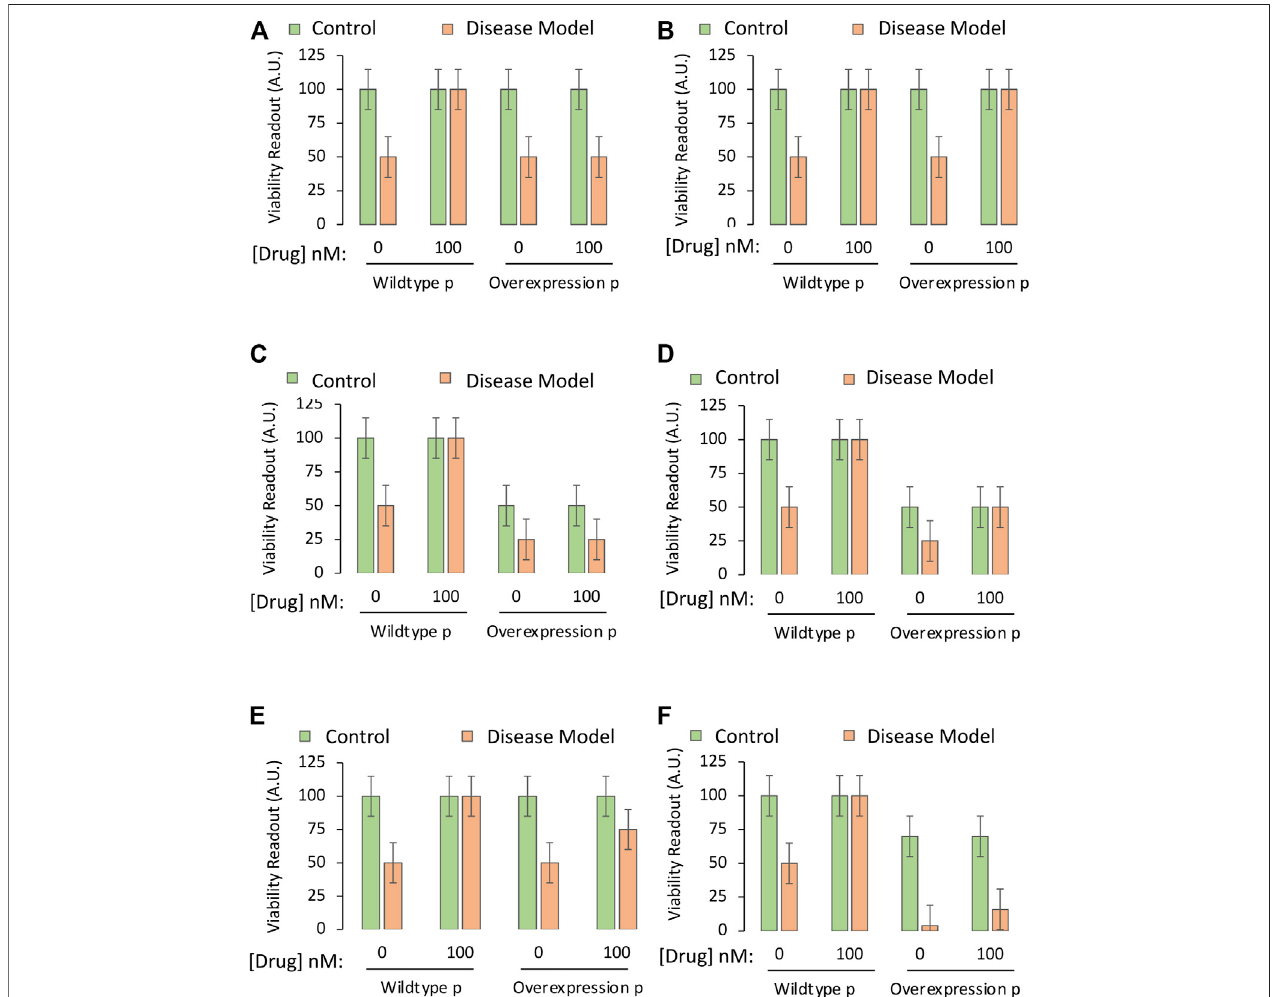
FIGURE 5 | Testing the mechanistic hypothesis by leveraging overexpression of the gene encoding a protein that is downregulated by the drug. A speci fi c and sensitive cell culture-based viability assay is used to screen whether the drug candidate exerts its protective impact through suppression of the function of the pro- apoptotic protein. The Y axes re fl ect cellular viability levels (the dependent variable), and the X axes indicate two independent variables: 1) Application of vehicle or the most protective concentration of the drug (as determined in Part I of this series), and 2) use of cells harvested from wildtype mice or genetically modi fi ed mice that overexpressthegenecoding forthepro-apoptoticprotein, labeled “ p ” .Theorange andgreenbars refertothethirdindependent variable, thedisease modelorthenon- diseased control, respectively. (A) The protective impact of the drug candidate is abolished when the pro-apoptotic protein is overexpressed. (B) Overexpression of the pro-apoptotic protein does not reduce the protective impact of the drug as hypothesized. (C) Overexpression of the gene reduces basal viability under physiological conditions and also abolishes the protective impact of the drug. (D) Overexpression of the gene reduces baseline viability under physiological conditions, but does not modify the protective impact of the drug. (E) Overexpression of the gene partially reduces the protective impact of the drug candidate. (F) Overexpression of the gene reduces basal viability under physiological conditions, but also synergizes with disease conditions to cause massive cell death, rendering it impractical to test the mechanistic